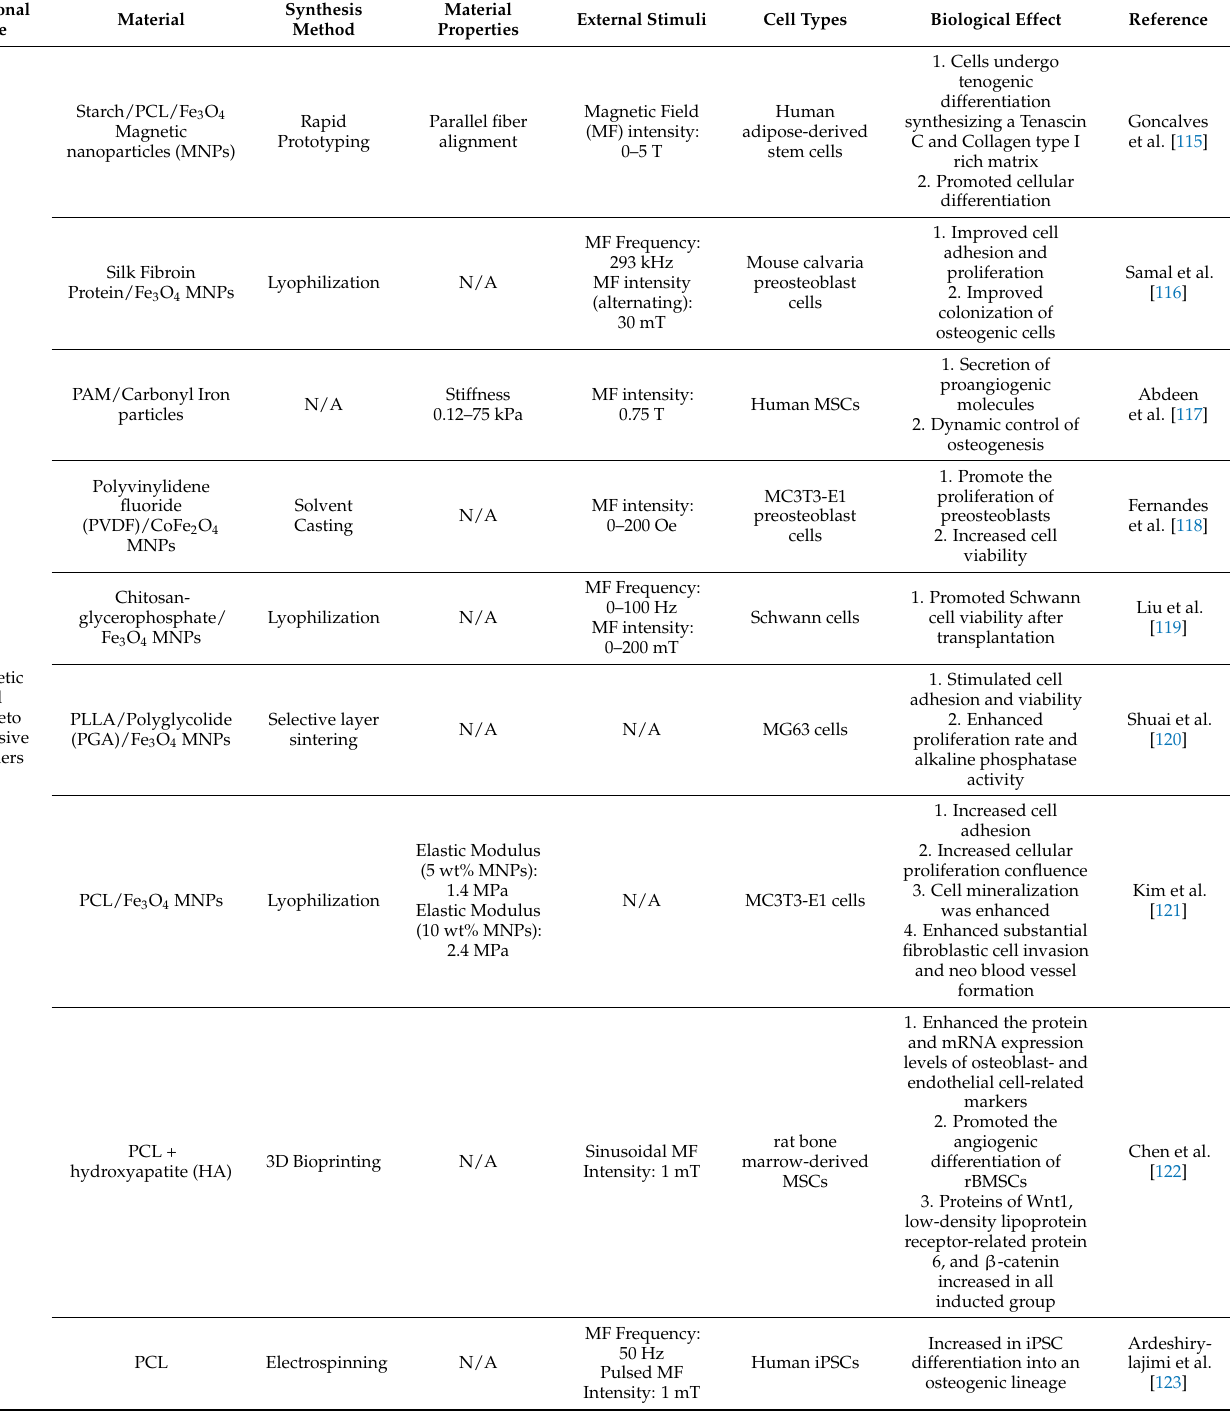
Table 3. Magnetic and magneto-responsive polymers and their tissue engineering